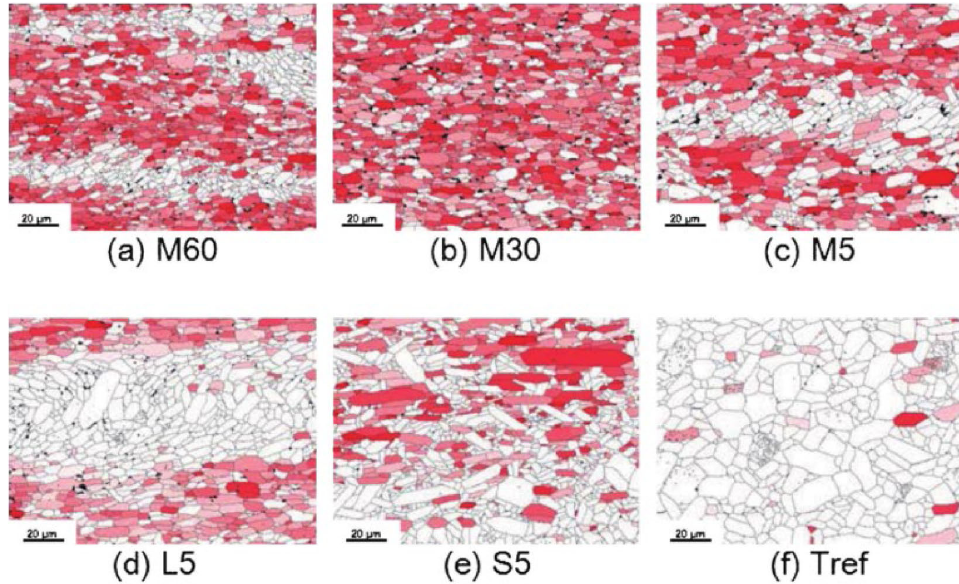
Fig. 15 Euler maps of α-Al 2 O 3 specimens prepared using different seeds of different amount (the vertical direction in the maps corresponds to the stacking direction of plate-like seeds). Reproduced with permission from Ref. [3], © The Ceramic Society of Japan